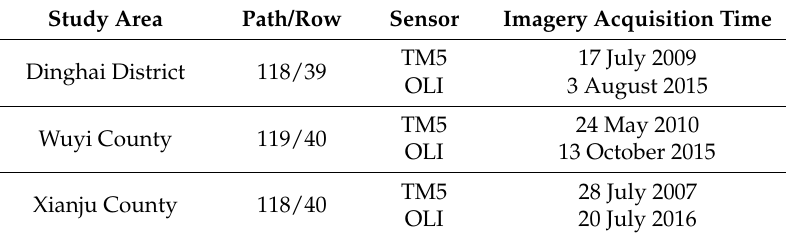
Table 2. Landsat imagery acquisition